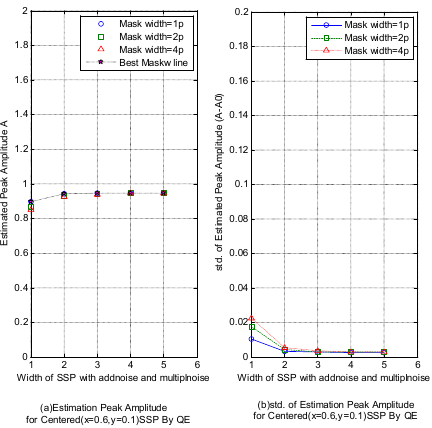
Figure 8 Peak position f